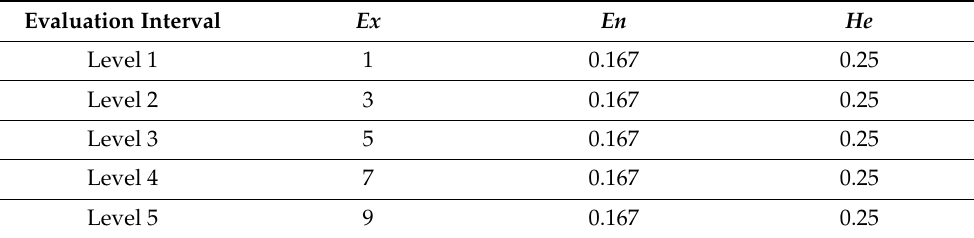
Table 3. Evaluation interval and standard evaluation cloud digital